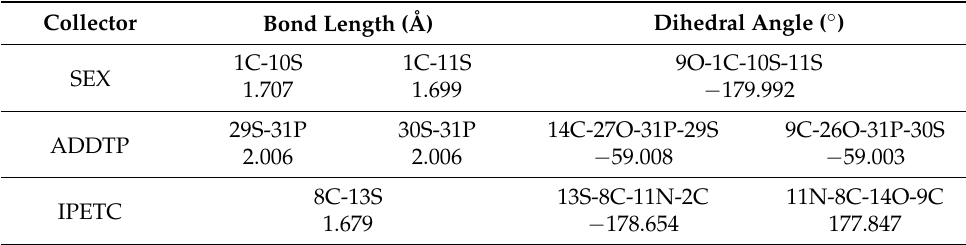
Figure 6. Optimized geometry configurations of collector molecules or ions (( a ) IPETC; ( b ) ADDTP; ( c ) SEX). Table 7. Bond lengths and dihedral angles of